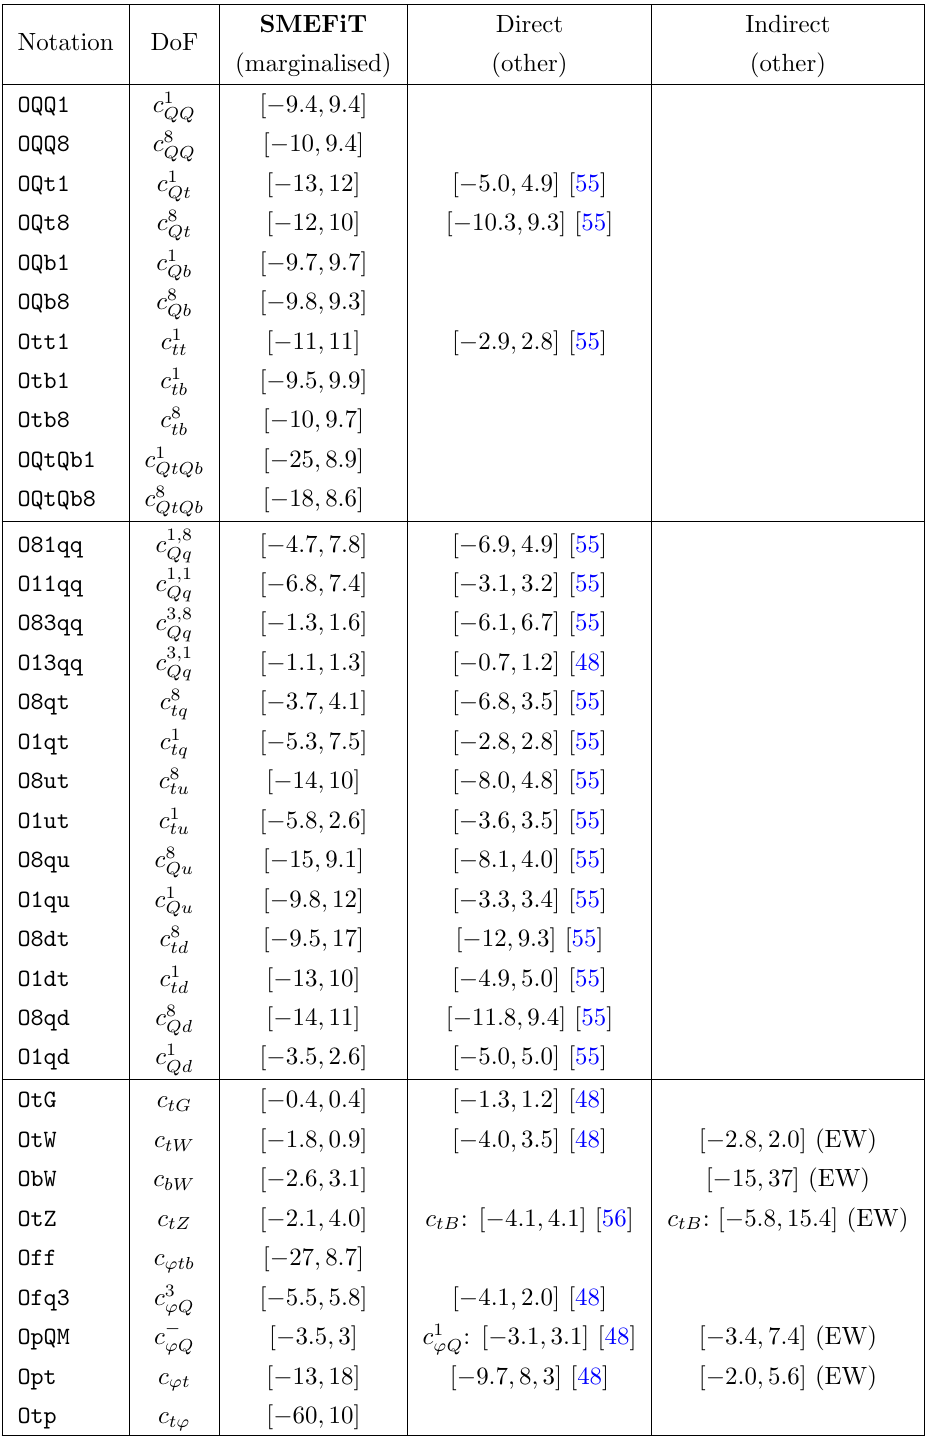
2 , assuming (cid:3) = 1 TeV) for the coef- Table 8 . The 95% con(cid:12)dence level bounds (in units of TeV (cid:0) (cid:12)cients of the 34 SMEFT degrees of freedom derived from the present analysis from the marginali- sation of the global (cid:12)t results. We also quote results obtained elsewhere from the direct analysis of top quark production and from indirect bounds from processes not involving top quarks.